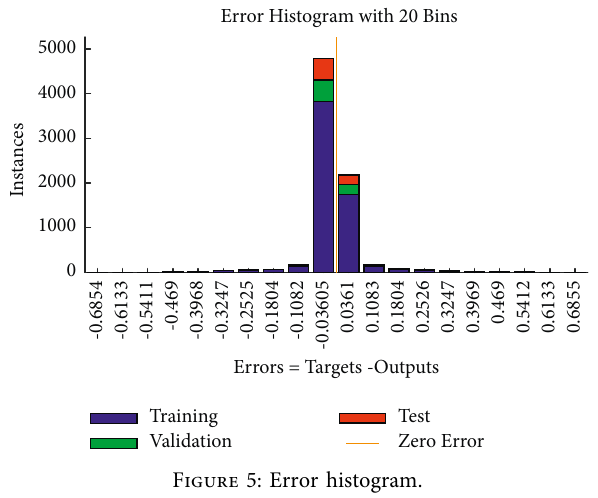
Figure 5: Error histogram.